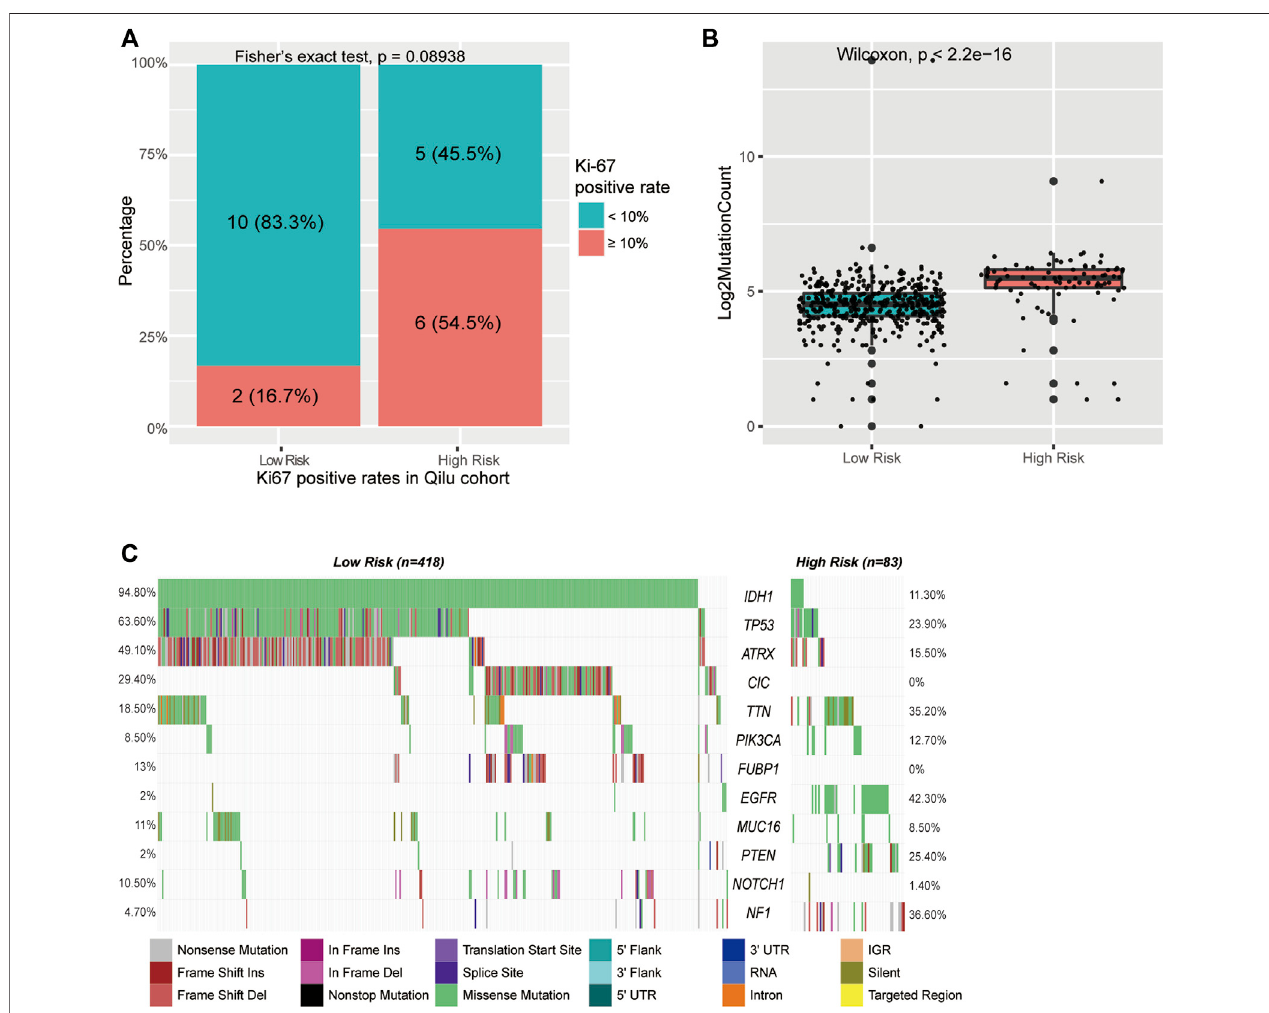
FIGURE8| MutationsinCpGsignature-strati fi edLGGs. (A) BarplotofKi-67levelindifferentgroupsintheQilucohort. (B) Boxplotofmutationcountsinthelow-risk group and high-risk group. (C) Mutation landscape in the low-risk group and the high-risk group.